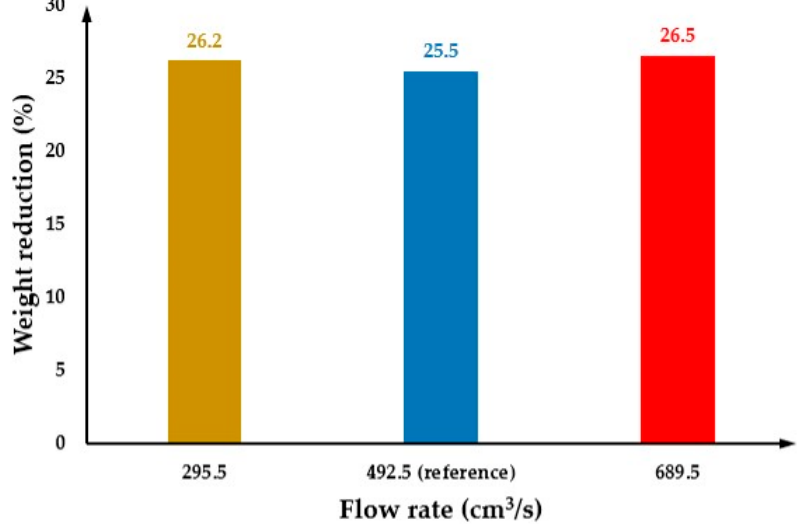
Figure 21. The weight reduction as a function of flow rate.